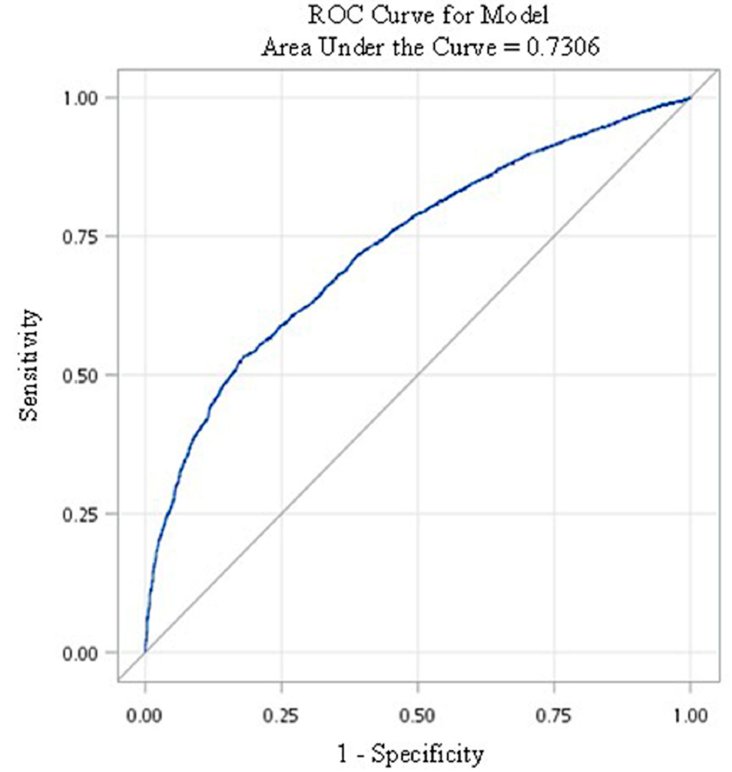
Figure 2. Receiver operating characteristic (ROC) curve of the predictive model for the high-risk population who had undergone oral cancer screening.